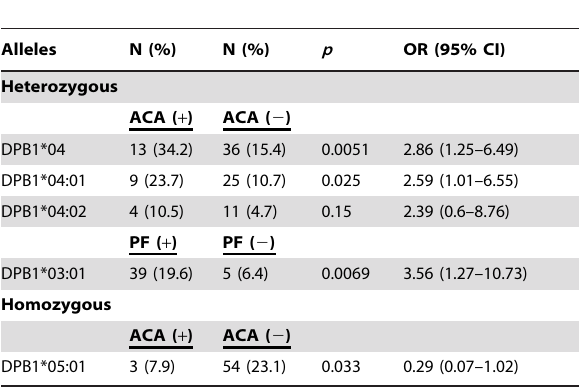
Table 3. Differentiation of SSc subsets and clinical outcomes with specific HLA-DPB1